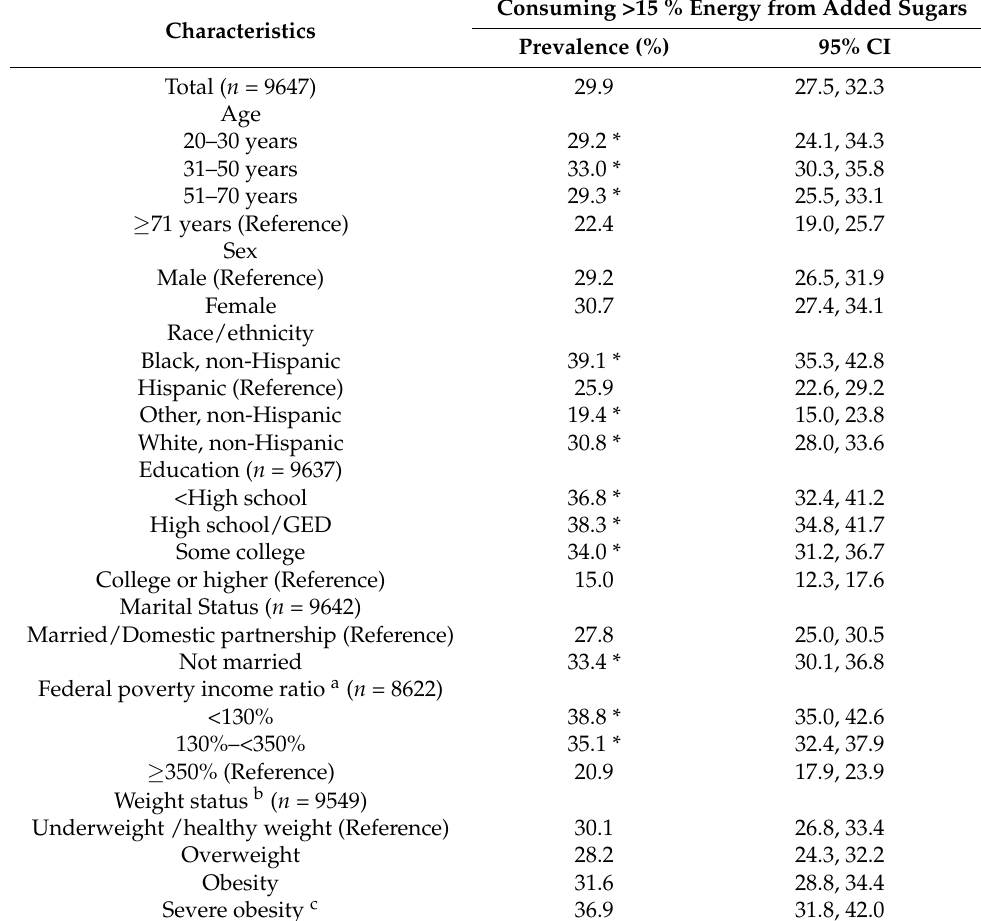
Table 2. Characteristics of US adults aged ≥ 20 years consuming greater than 15 % energy from added sugars, NHANES 2015–2018, usual